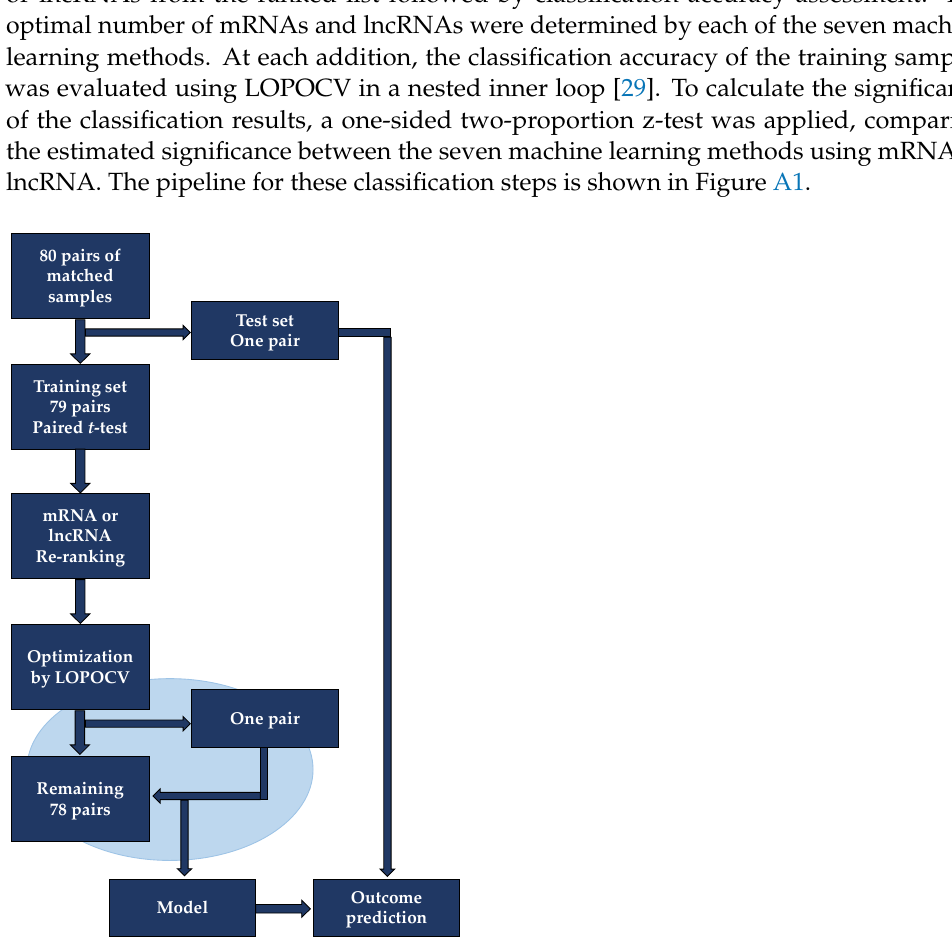
12 of 16 optimized balanced accuracy. Both strategies were followed by voting with a final sensi- tivity of 90%. For the first approach, the optimal model during training was selected based on a fixed sensitivity of ≥ 90% while the specificity was maximized, assessed by leave-one-pair-out cross-validation (LOPOCV). Using the second approach, the optimal model was determined based on mean sensitivity and specificity maximization, likewise assessed by LOPOCV. In brief, LOPOCV is a procedure that evaluates how well a machine learning method performs by using a single pair of matched samples as test samples, while the remaining samples serve as a training set. Each single pair of matched samples was thus tested individually, and the procedure was repeated until all pairs of matched samples had been left out once. The accuracy of the machine learning methods was determined by the amount of correctly classified samples. An unbiased performance estimate is pro- vided by this procedure, and this approach has furthermore proven to be optimal for analysis of smaller datasets [27,28]. Feature selection is required in the training set to avoid a small sample-per-feature ratio and it has been shown to provide better classification [28]. In this study, the feature selection process comprised of three steps: 1) Testing the mRNAs and lncRNAs in the